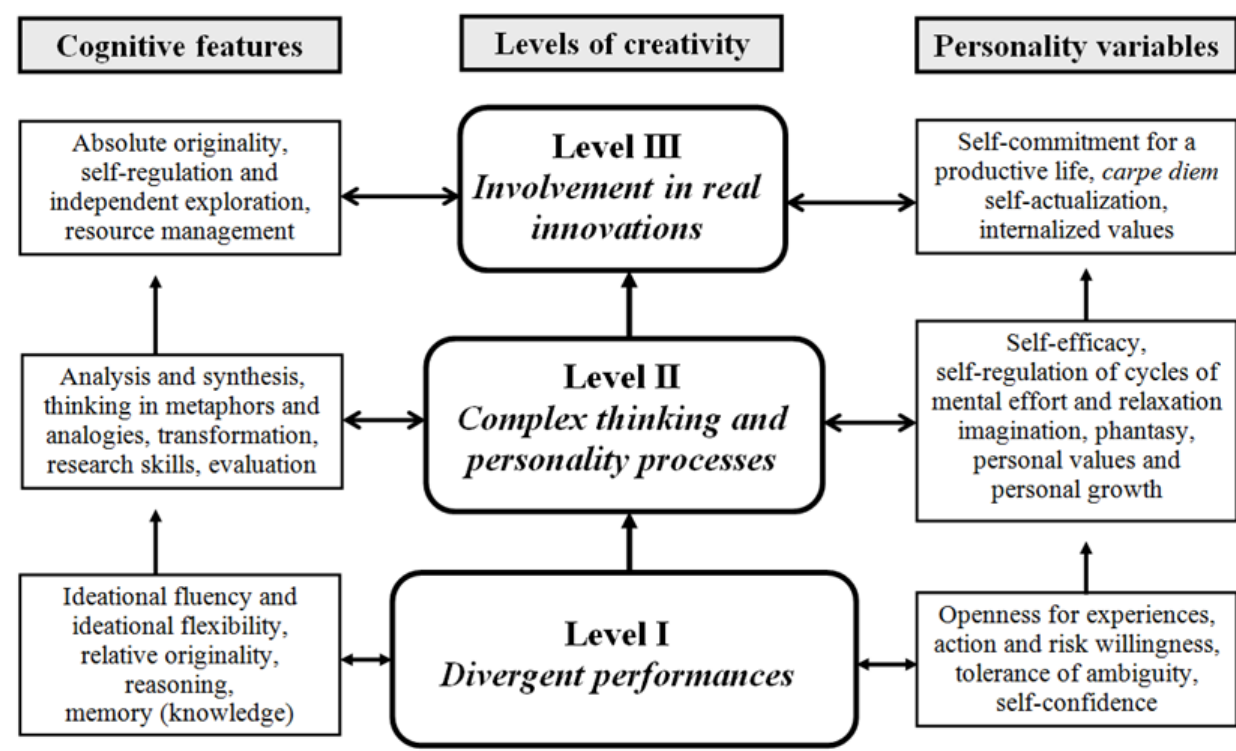
Figure 1. Integrative 3-level model of creativity with attached cognitive and personality characteristics (Krampen et al., 2012, p. 80; extended modification of the proposal by Treffinger, 1980).